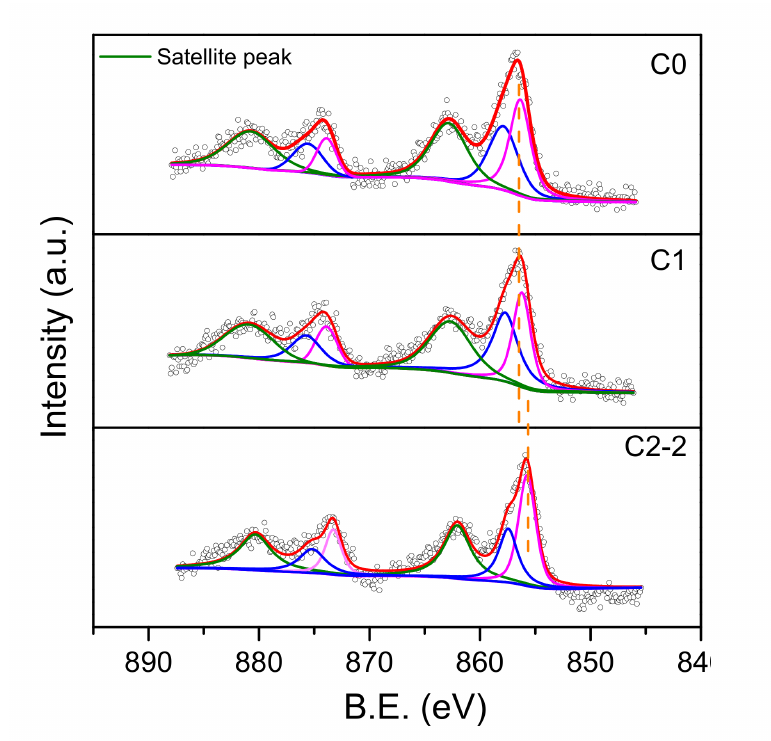
Figure 5. Ni 2p XPS spectra of the samples after calcination. (C0) 10Ni / Al 2 O 3 , (C1) 10Ni4Cu / Al 2 O 3 , and (C2-2) 10Ni4Zn / Al 2 O 3